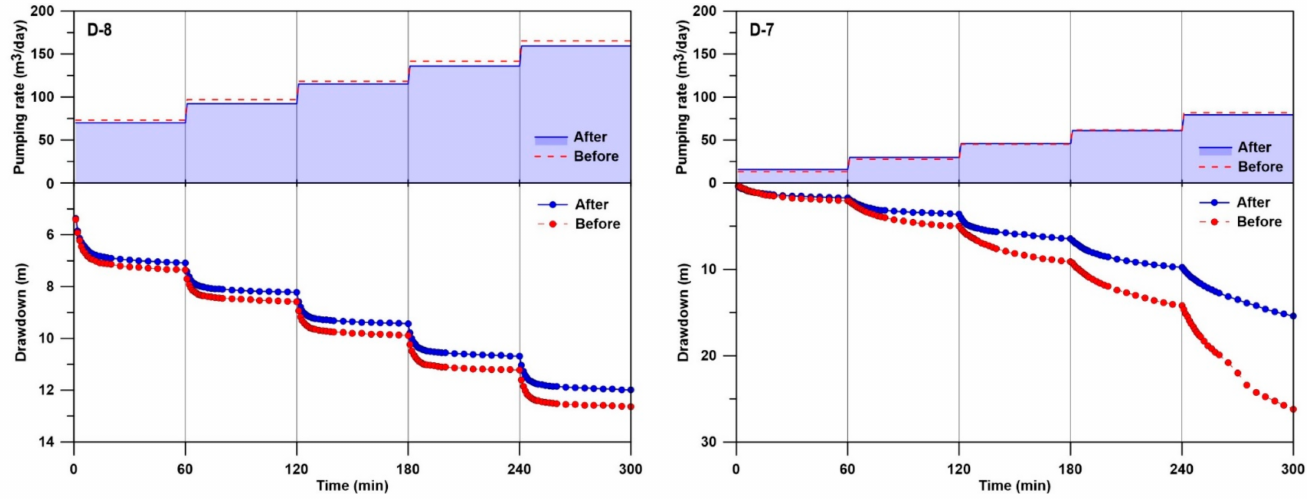
Figure 3. Groundwater drawdowns of the D-7 and D-8 wells during the step drawdown